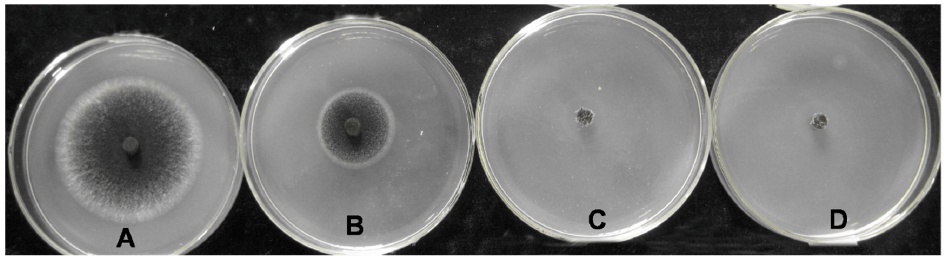
Figure 1. The growth of C. paradoxa on PDA medium with HmB 10 ug / mL, ( A ); 20 ug / mL, ( B ); 30 µ g / mL, ( C ); 40 µ g / mL, ( D